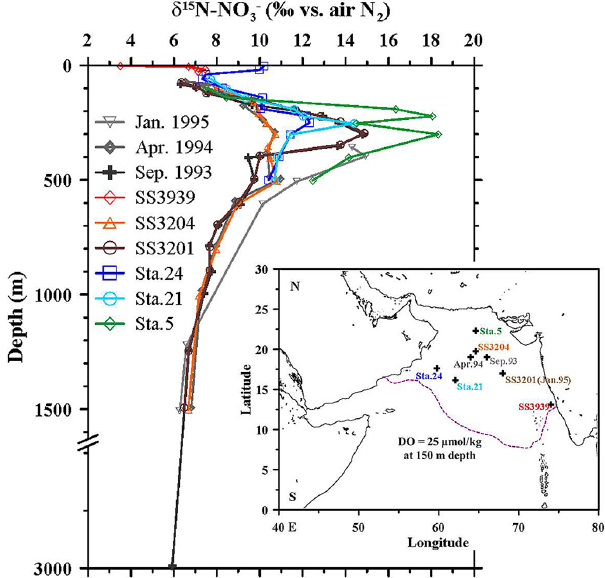
Figure 5. Depth profiles of nitrogen isotope of nitrate ( δ 15 N NO water columns; data not marked are all from August; the location of Station January 1995 overlaps with Station SS3201 (data digitized from Brandes et al., 1998; Altabet et al., 1999; Naqvi et al., 2006).